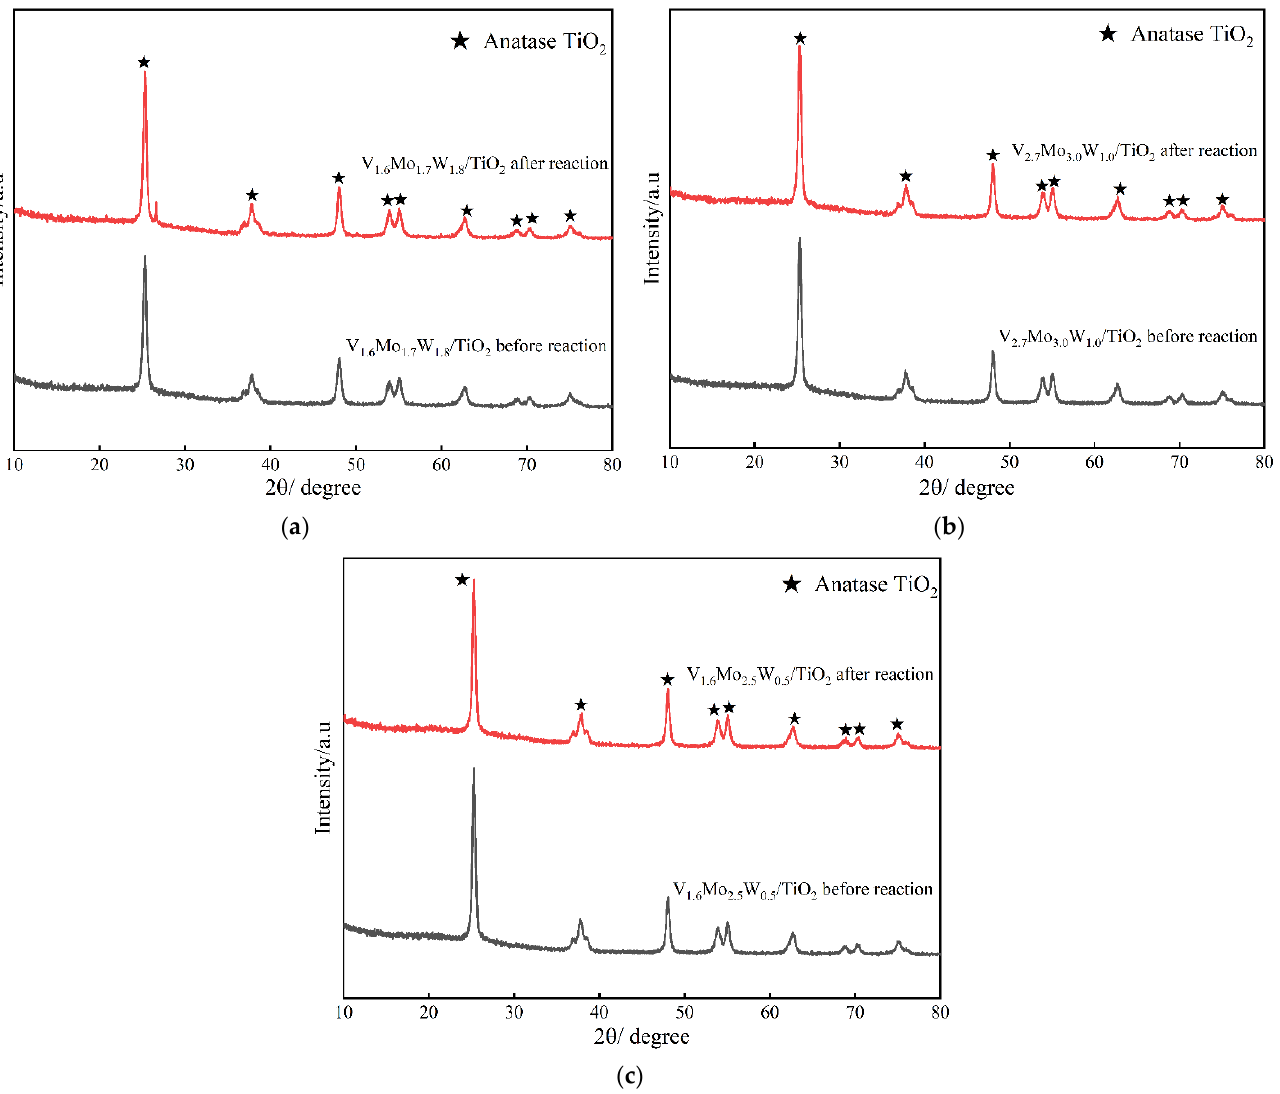
Figure 7. XRD pattern of three catalysts: ( a ) V 1.6 Mo 1.7 W 1.8 /TiO 2 ; ( b ) V 2.7 Mo 3.0 W 1.0 /TiO 2 ; ( c ) V 1.6 Mo 2.5 W 0.5 /TiO